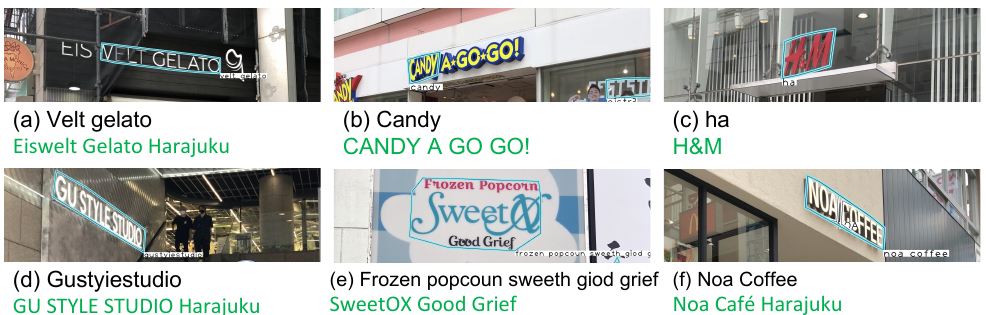
Figure 4. Examples of observed place retrieval challenges: ( a ) Partial recognition due to occlu- sion; ( b ) Partial detection by the text spotter; ( c ) Occurrence of symbols; ( d ) Mismatching spacing; ( e ) Challenge in separating place name and tag line; ( f ) Occurrence of common words (Coffee) and discrepancies between display name and listed name. (Recognized display text and listed place name is given below each image).